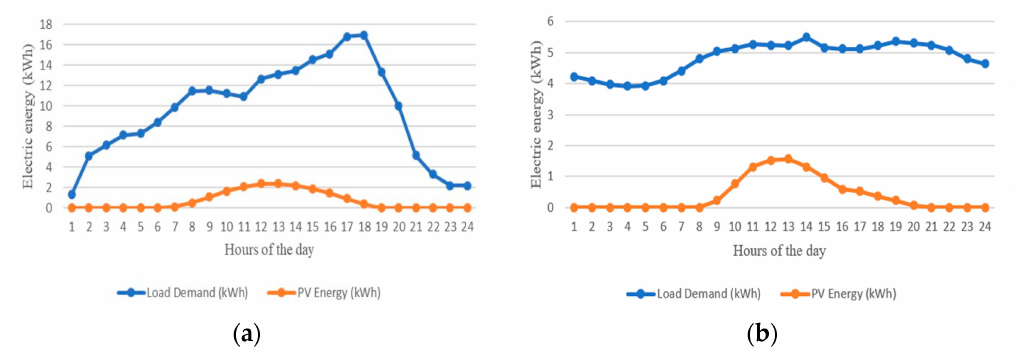
Figure 3. Average load demand and single PV module output for: ( a ) case 1; ( b ) case 2.